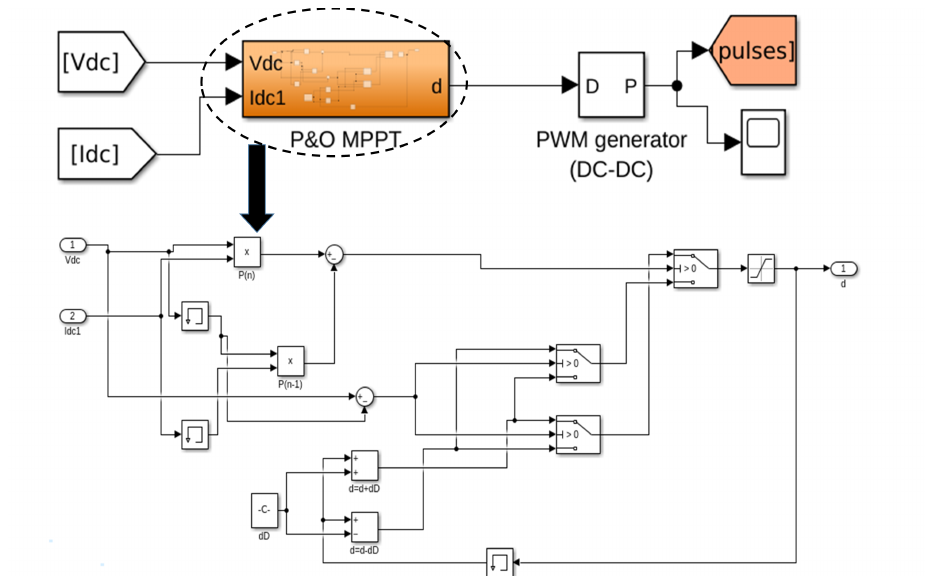
Figure 12. SIMULINK block for the P&O method.